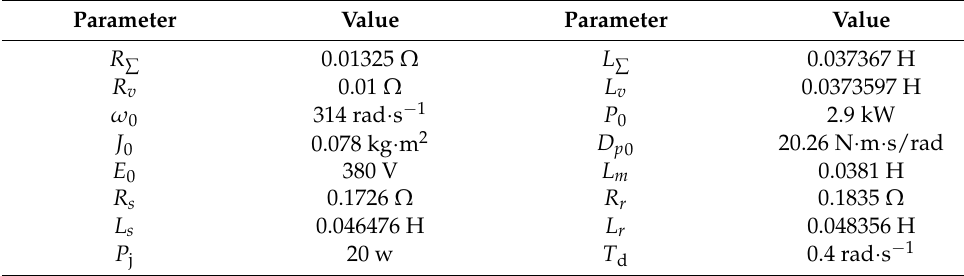
Table A1. Parameters of the DFIG-IFLVSG wind power grid-connected